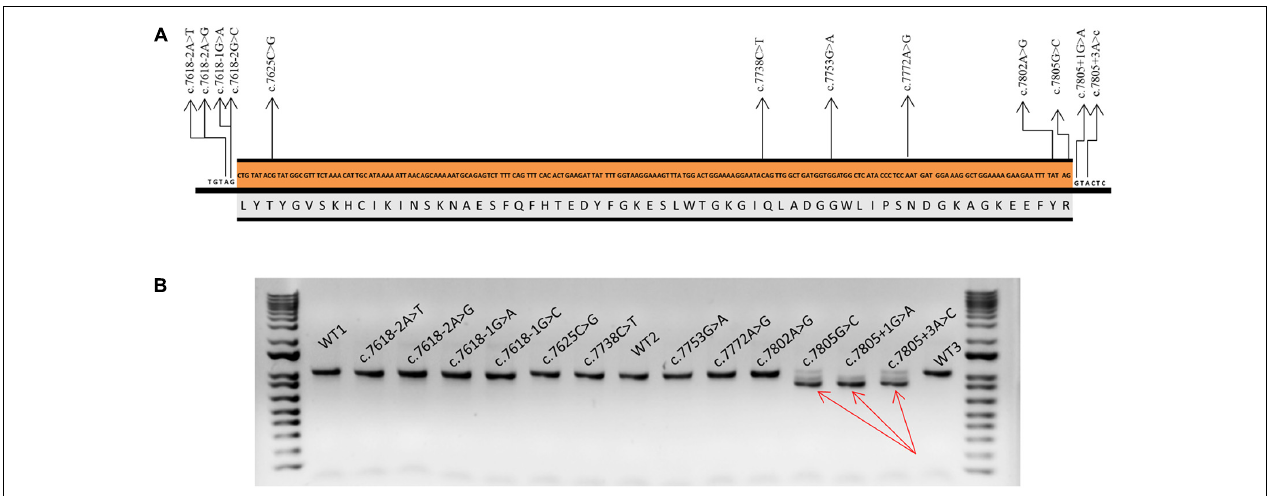
FIGURE 1 | Functional assays of spliceogenic candidate variants of BRCA2 exon 16. (A) Nucleotide (c.7618_7805) and amino acid (p.2540_2602) sequences of BRCA2 exon 16. Arrows indicate selected variants. (B) Agarose gel electrophoresis of RT-PCR products of the wt and mutant minigenes and the size standard 1 Kb Plus DNA Ladder at both sides of the gel. Amplification was made with primers pMAD607-FW and RTBR2_ex17RV2. Full-length transcript (V1-EX17) size: 1018 nt. Red arrows point to exon 16 skipping band ( (cid:49) 16) (size: 830